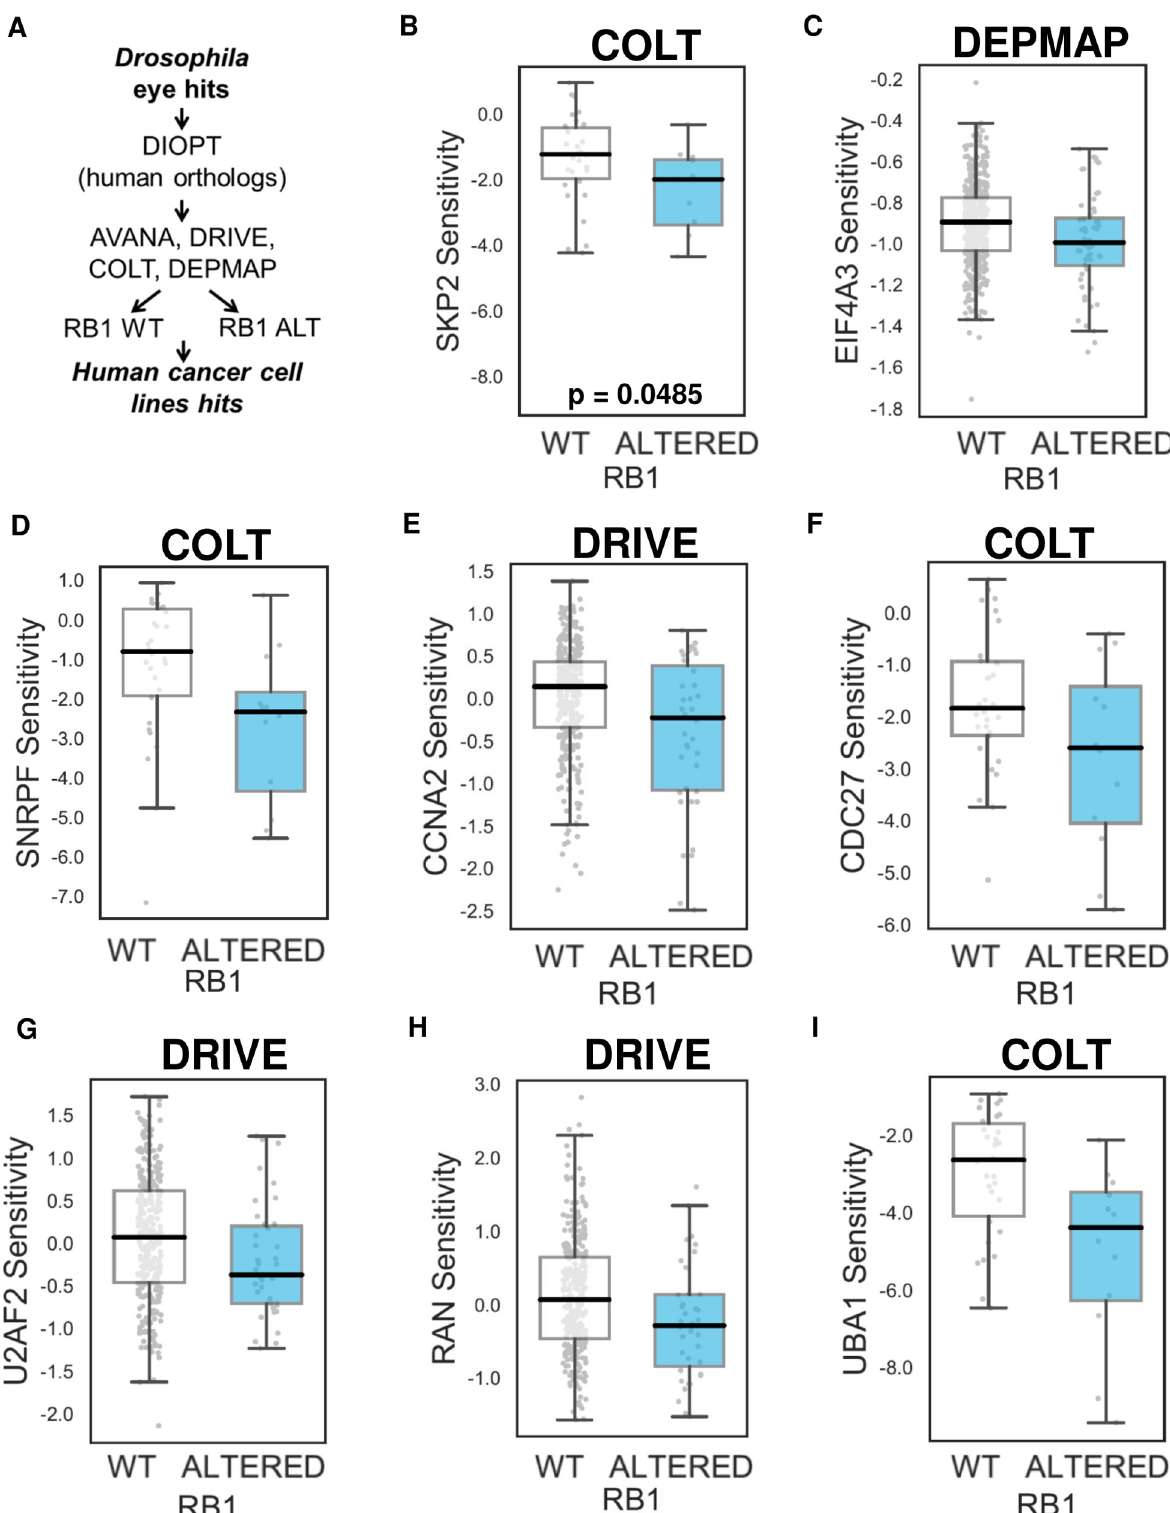
Fig 2. Testing human gene orthologs of the Drosophila hits in available large-scale shRNA and CRISPR human cancer cell line screens. Data analysis workflow (A) . Scatter plots illustrating Z scores in DRIVE, AVANA, COLT, DEPMAP data sets in RB1 wild-type (WT) and mutant